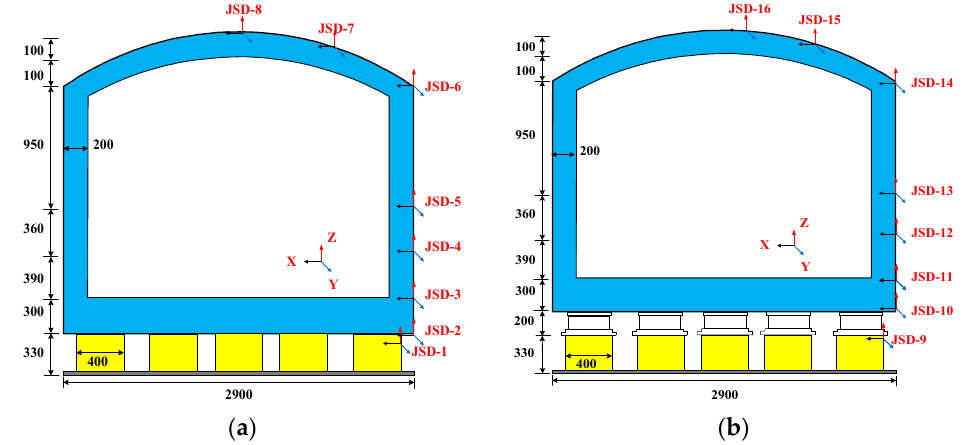
Figure 1. Dimensions of the test tank model: ( a ) Non-isolated storage tank; ( b ) Isolation storage tank.